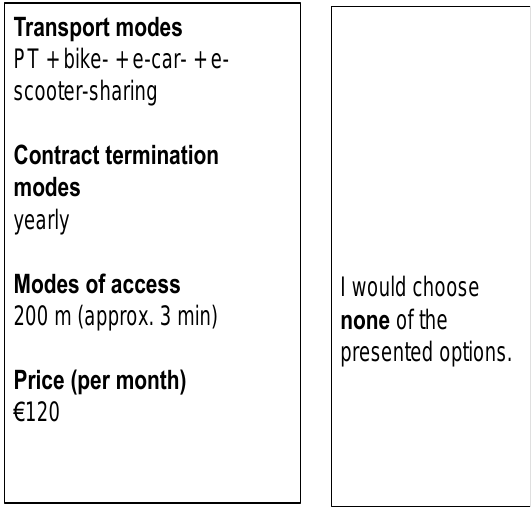
Figure 1. Example of choice tasks.